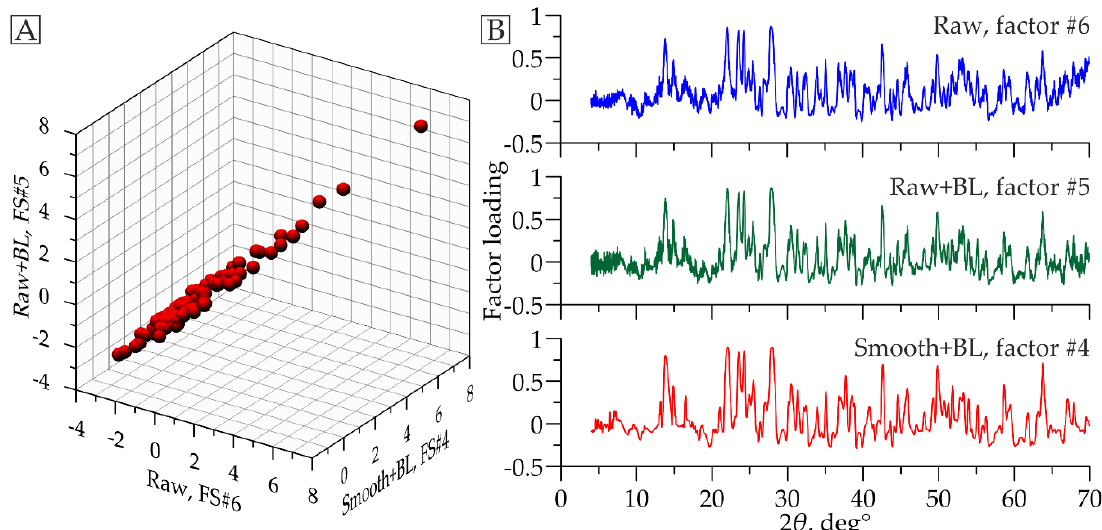
Figure 6. ( А ) An example of a robust linear relationship between the factor score ( FS ) values of analogous factors resulting from factor analysis of three XRPD datasets: “Raw”—raw data without spectral operations; “Raw + BL”—raw data with baseline correction; “Smooth + BL”—smoothed data with baseline correction. ( B ) Comparison of factor loadings graphs of the same factors.